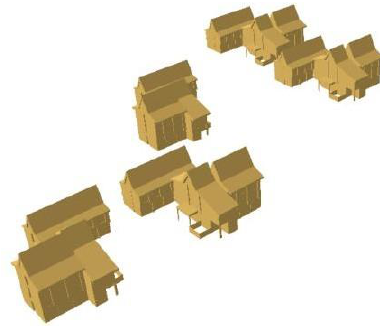
Figure 18 the presentation of 3d city